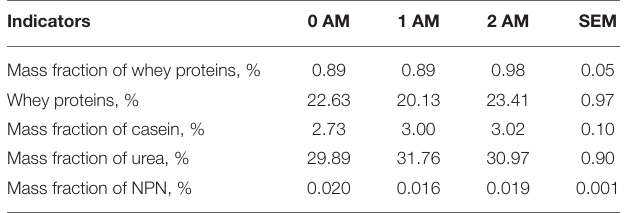
TABLE 9 | Biochemical parameters of cows’ blood at the end of the lactation